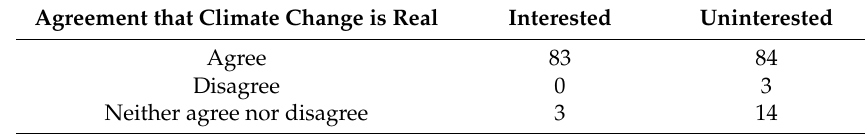
Table 5. Interest and belief in climate change.